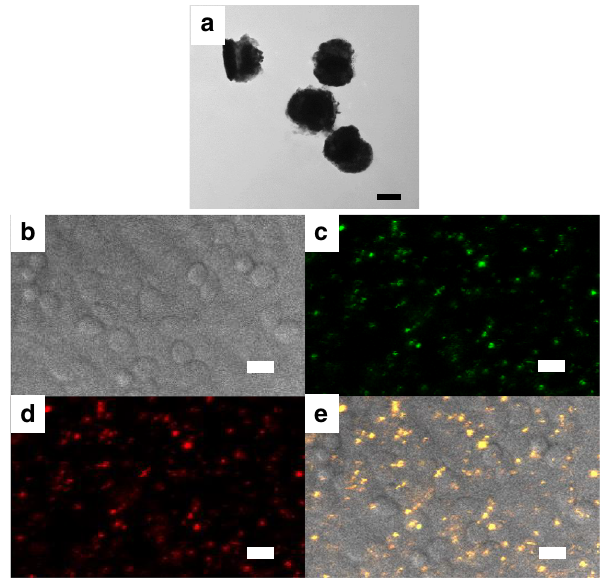
Fig. 5 Metal – insulator – metal dispersal and incubation into cells. a Transmission electron miscroscopy (TEM) images of the metal – insulator – metal (MIM) structures after dispersal in water. The well- de fi ned metal and insulator layers in the image demonstrate that the structure is robust and maintains structural integrity through the lift off process. b – e Confocal laser scanning microscopy images of T24T bladder cancer cells incubated with MIM structures. b Bright fi eld image of cells, c Green, and d red upconverion fl uorescence collected upon 980 nm excitation show characteristic UCNP signal. e Overlay of green and